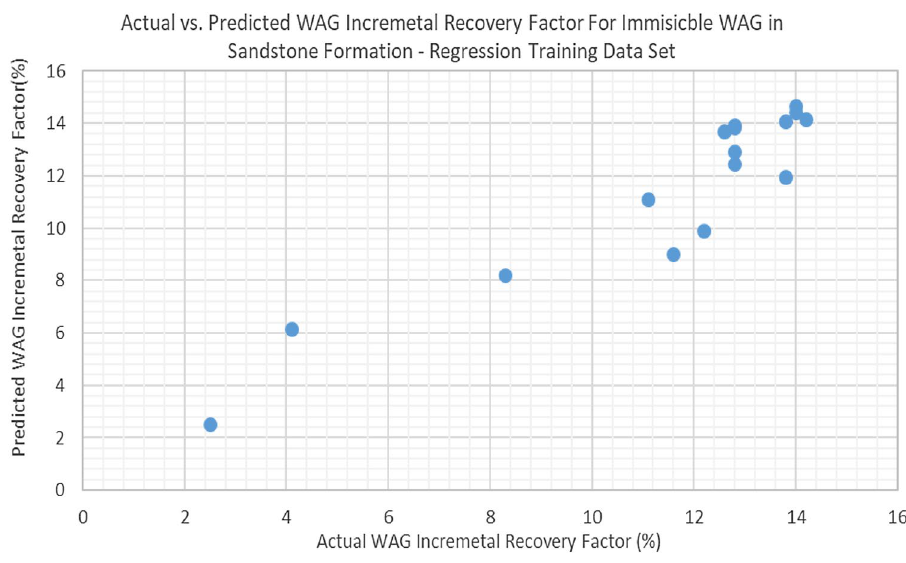
Fig. 8 Regression WAG incremental recovery factor prediction model training results for miscible WAG in carbonate